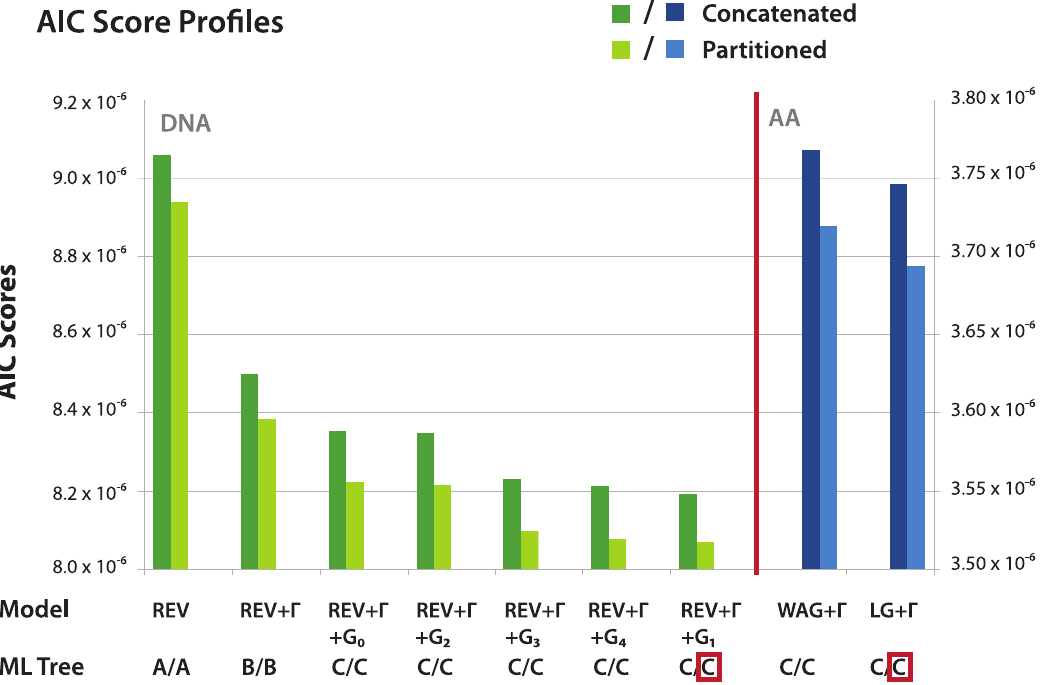
Figure 4. AIC score profiles for supermatrix analyses, differentiated by evolutionary model and type of analysis. Partitioned analysis (light colors) consistently outperformed concatenated analysis (dark colors). The choice of a partitioned vs. concatenated model does not affect which tree was found to be optimal when analyzing nucleotide data (green) as well as amino acids (blue). The ML topology obtained using the optimal model for both nucleotide and amino acid data is the same (red boxes) and is depicted in Figure 5. Trees A, and B are depicted in Supplementary Figure S4. doi:10.1371/journal.pone.0022783.g004 PLoS ONE |